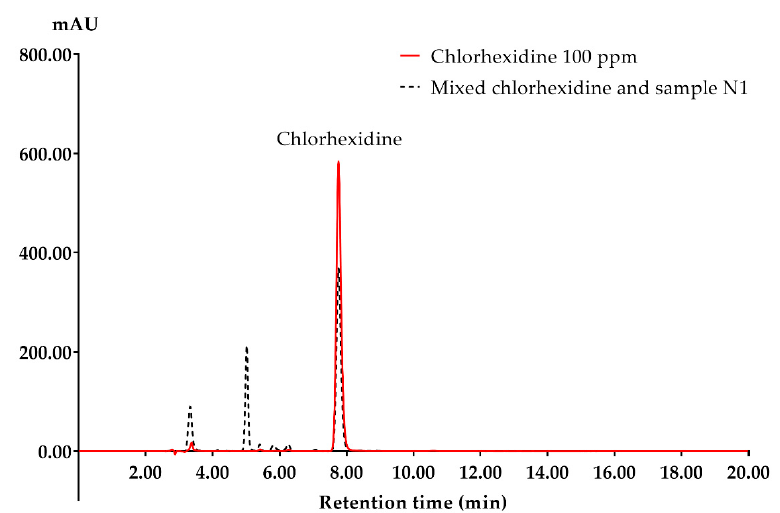
Figure 2. HPLC chromatogram of standard CHG and mixed CHG with lubricating gel sample N1.